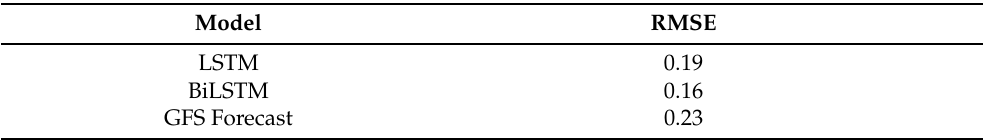
Figure 15. Comparison of significant wave height from wave observation with result of prediction by using BiLSTM at offshore of Meulaboh. Table 8. Comparison between the significant wave height Hs from wave observation at Meulaboh with GFS forecast results, downscaling using LSTM and